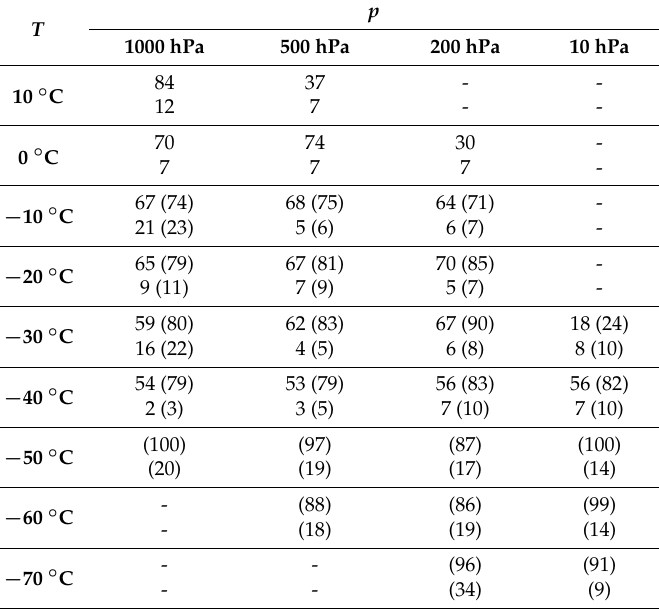
Table 1. Range of the relative humidity of CO 2 under investigation (minimum and maximum values) for different temperature and pressure conditions. The relative humidity (Equation (1) and Section 3.2 in [8]) is calculated with respect to water U w or ice U i (marked by brackets). T denotes humid gas temperature (in ◦